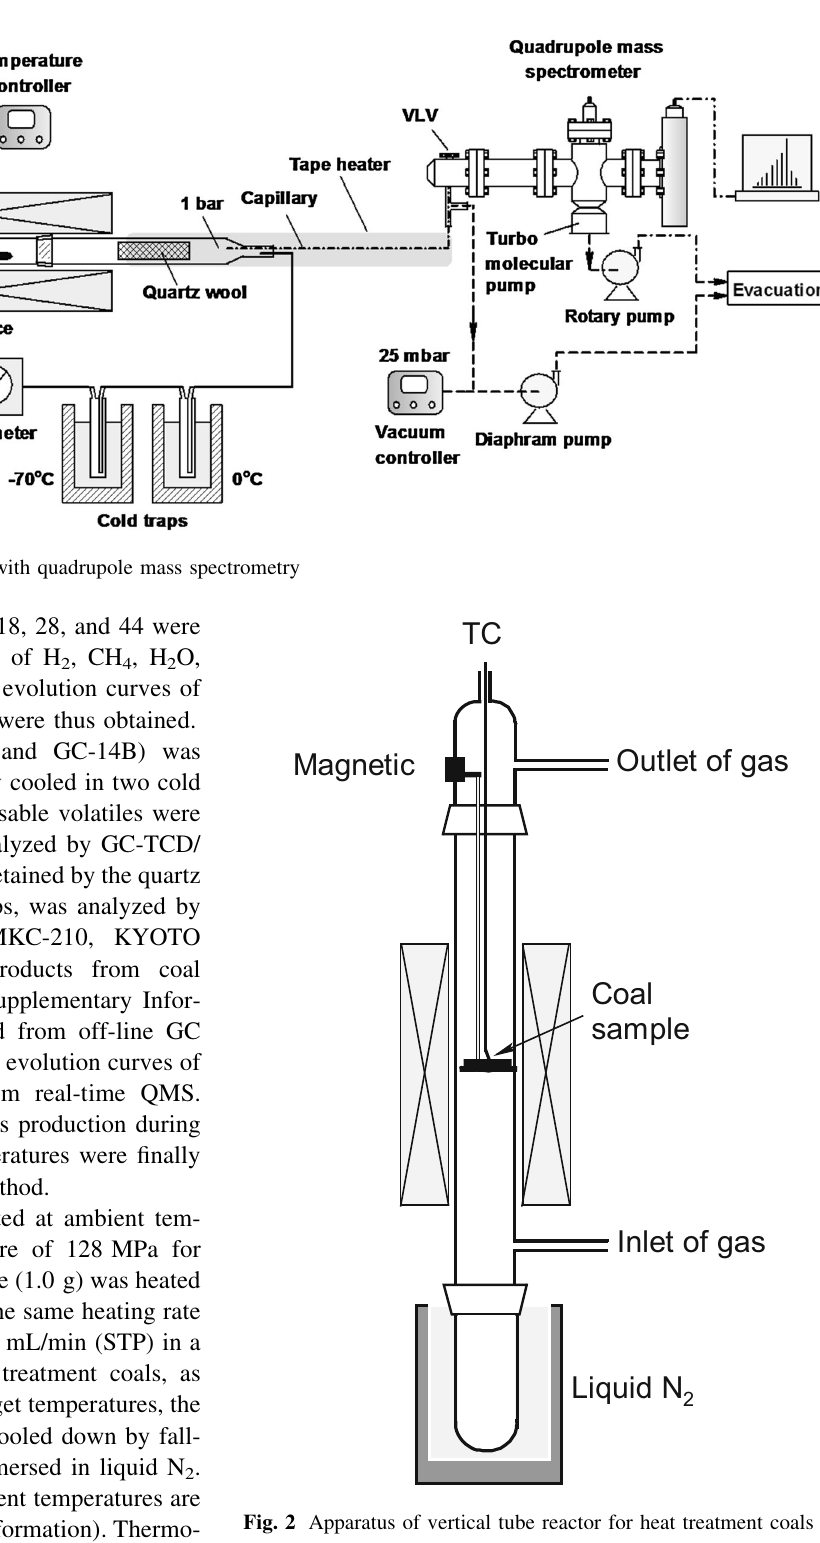
Fig. 2 Apparatus of vertical tube reactor for heat treatment